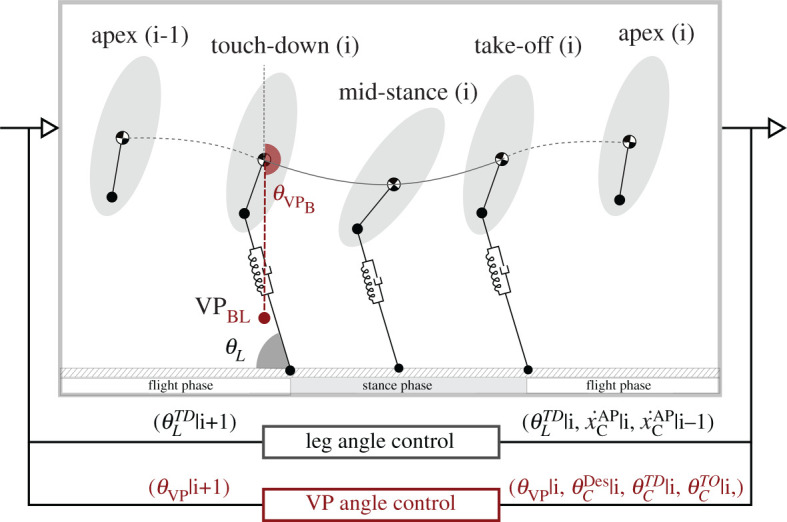
The linear feedback control scheme for the leg angle in equation (2.5) and the VP angle in equation (2.6) are presented. Both controllers update step-to-step at the apex event where the CoM reaches to its maximum height.